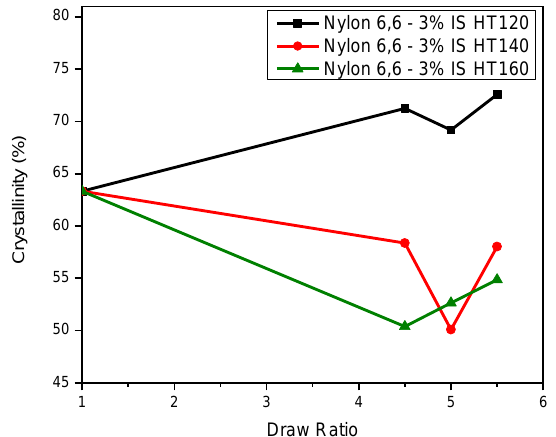
Figure 7. The orientation angle of the salt-confined nylon 6,6 fibres versus the drawing ratios of 1.0, 4.5, 5.0 and 5.5 at different drawing temperatures. 4.5, 5.0 and 5.5 at different drawing temperatures.